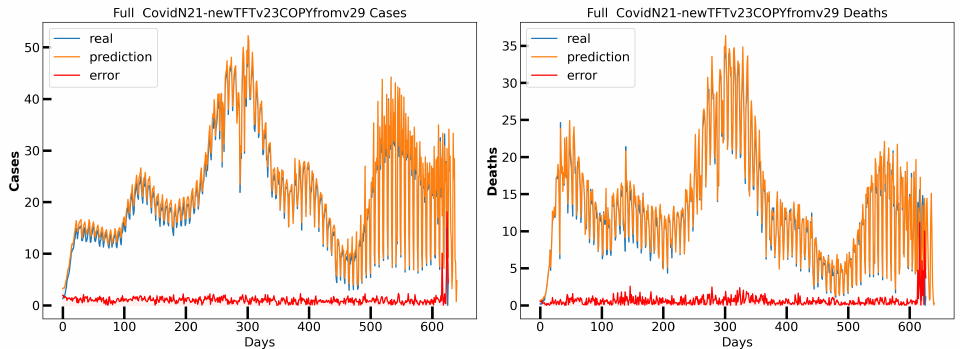
Figure 12. Modified TFT description of 500 most populous counties in the USA for COVID-19 daily infection and fatality data showing strong weekly periodic structure from early 2020 to November. Individual counties are scaled so all lie between 0 and 1 and the figure shows the sum of the square root of the number of recorded daily events in